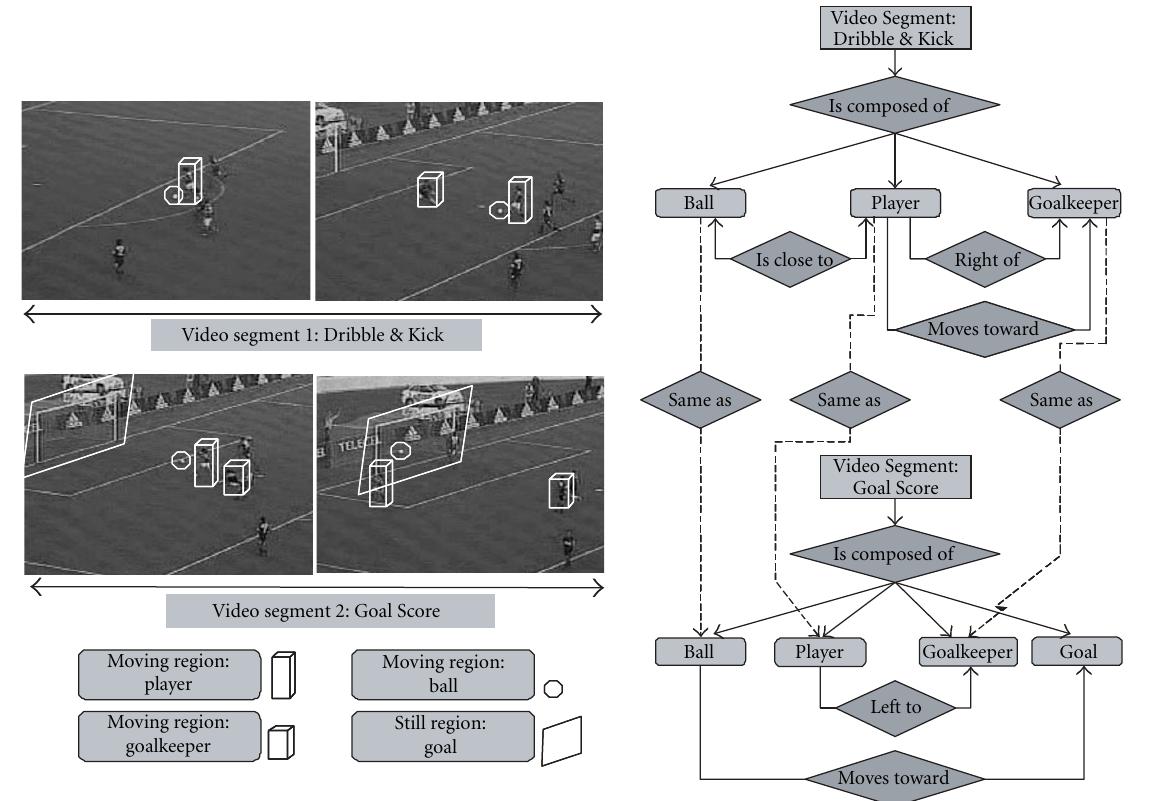
Figure 7: Examples of segment